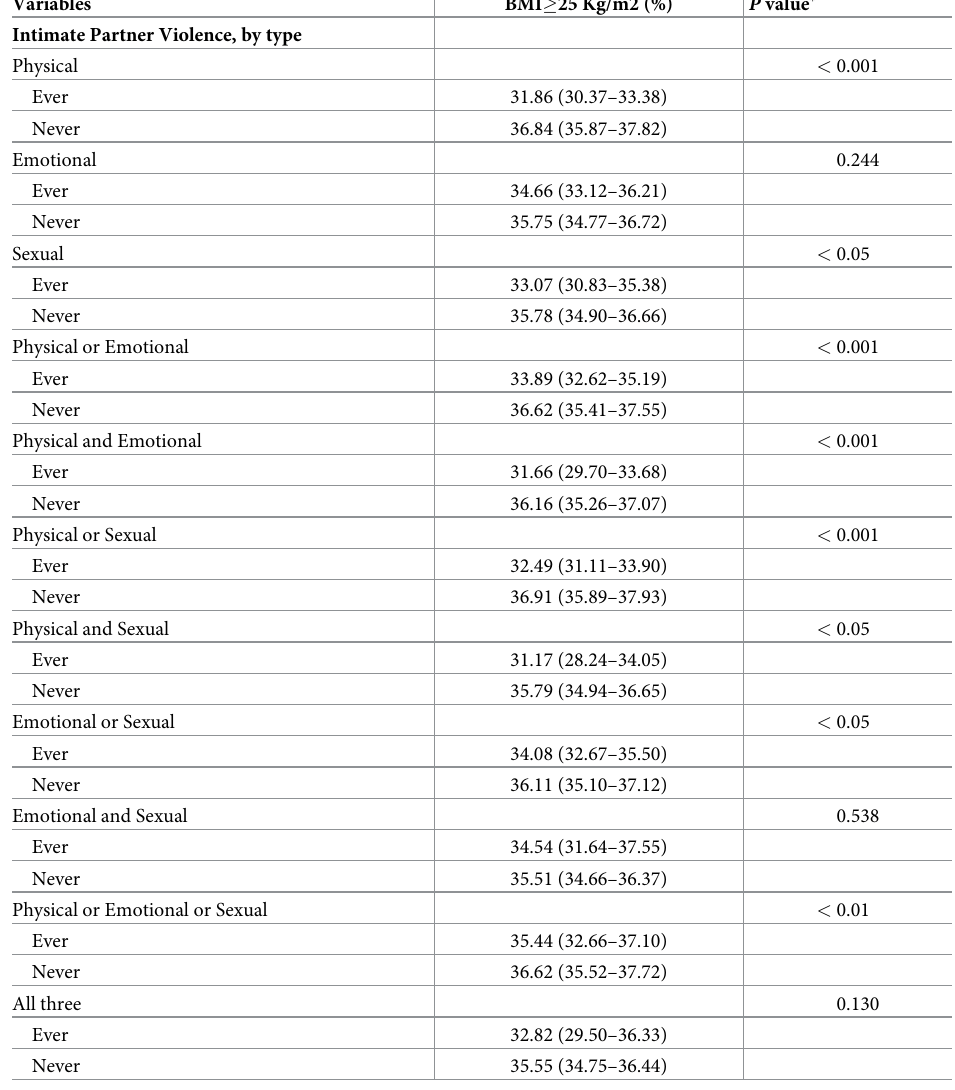
Table 2. Prevalence of BMI � 25.0 kg/m 2 (overweight and obesity) among women of reproductive age (15–49 years) by intimate partner violence type, Zimbabwe, pooled data, 2005–2015. Variables BMI � 25 Kg/m2 (%) P value